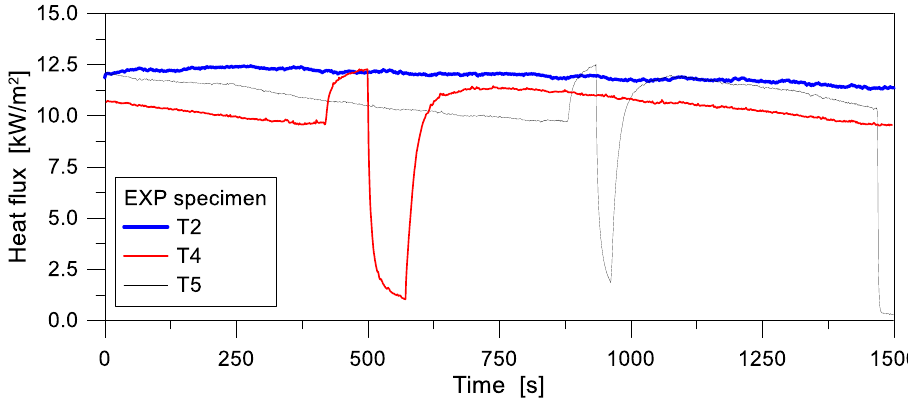
Figure 4. Experimentally measured heat flux histories (at the side of samples, see Figure 3a) for the specimens T2, T4 and T5.